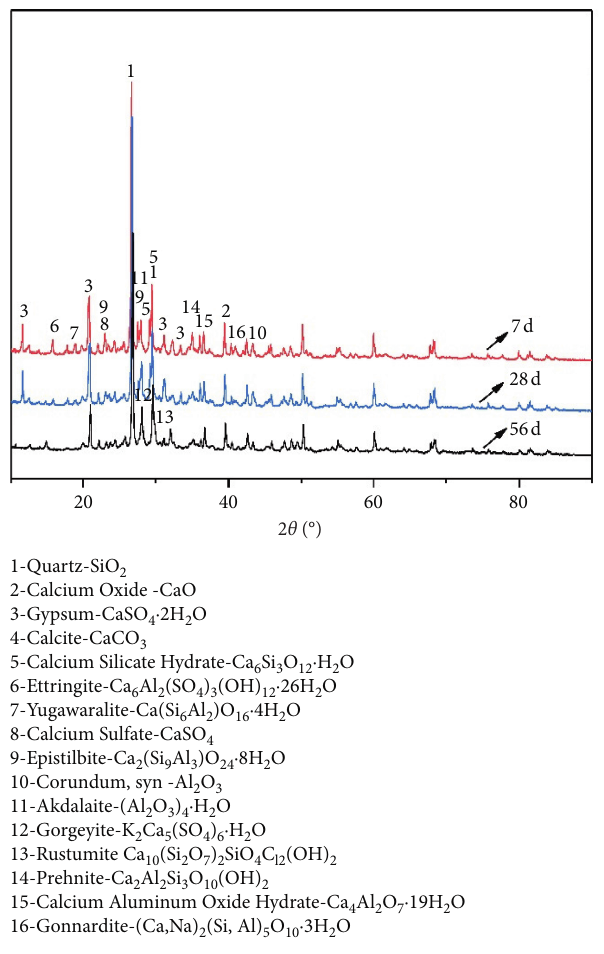
Figure 11: XRD pattern of samples at different curing time periods ( C